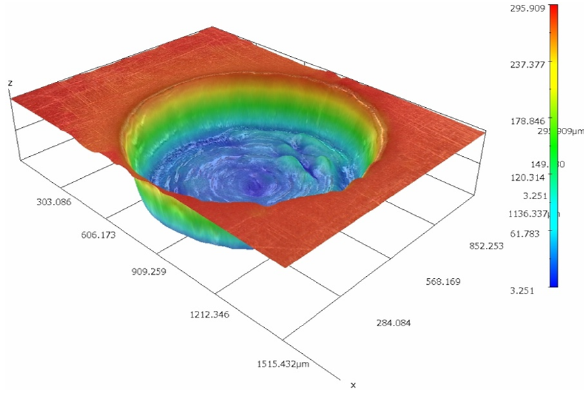
Figure 11: 3D profile of the second sample for trajectory No. 3.